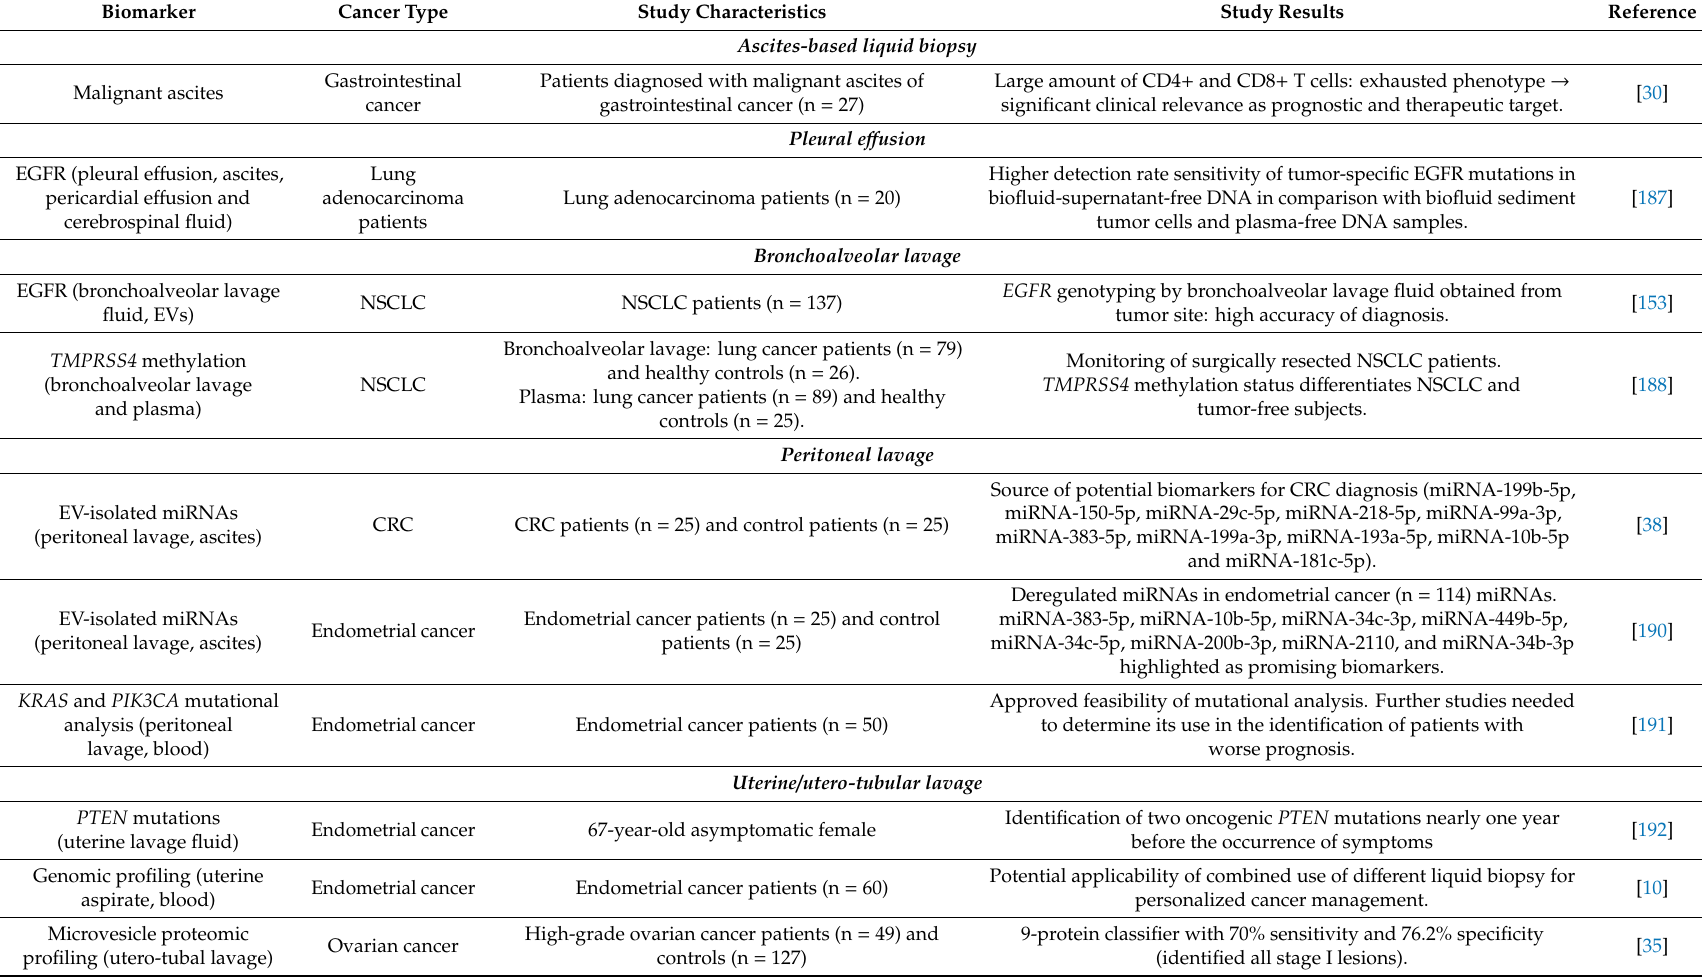
Table 6. Liquid biopsy based on other biofluids: the use of a broad spectrum of molecules as potential cancer